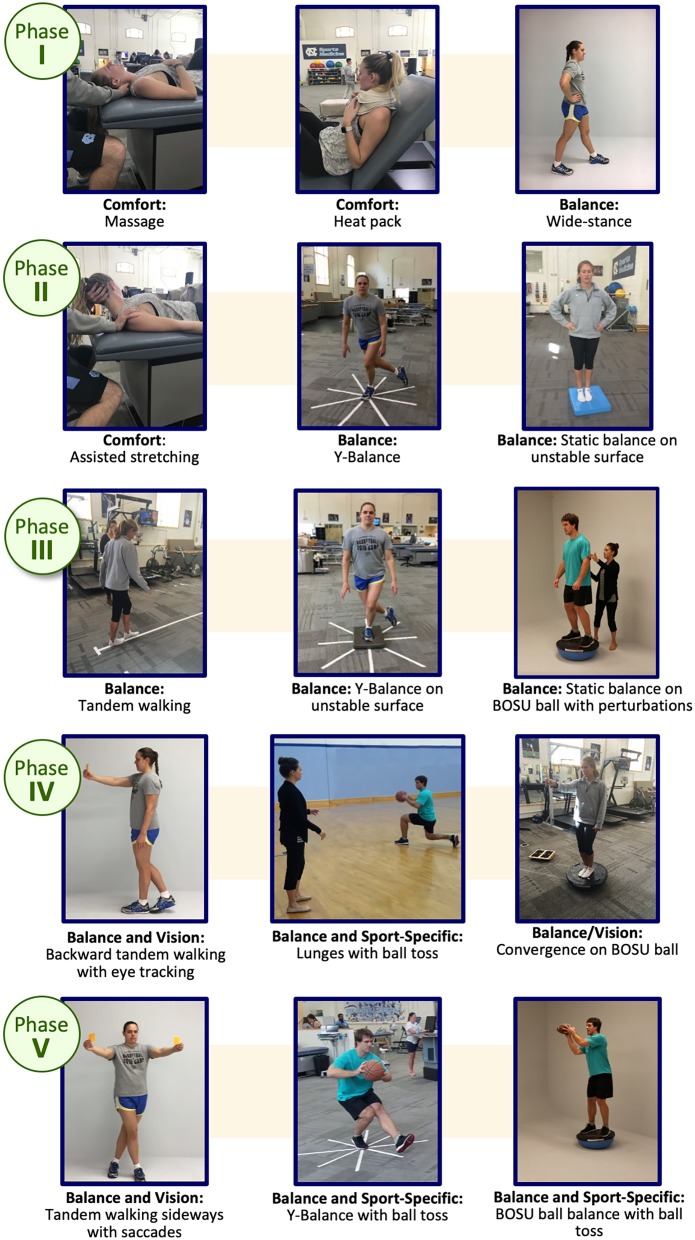
Example Balance Activity Progression through the Multidimensional Rehabilitation (MDR) framework. Written informed consent was provided by all individuals in the images for publication.